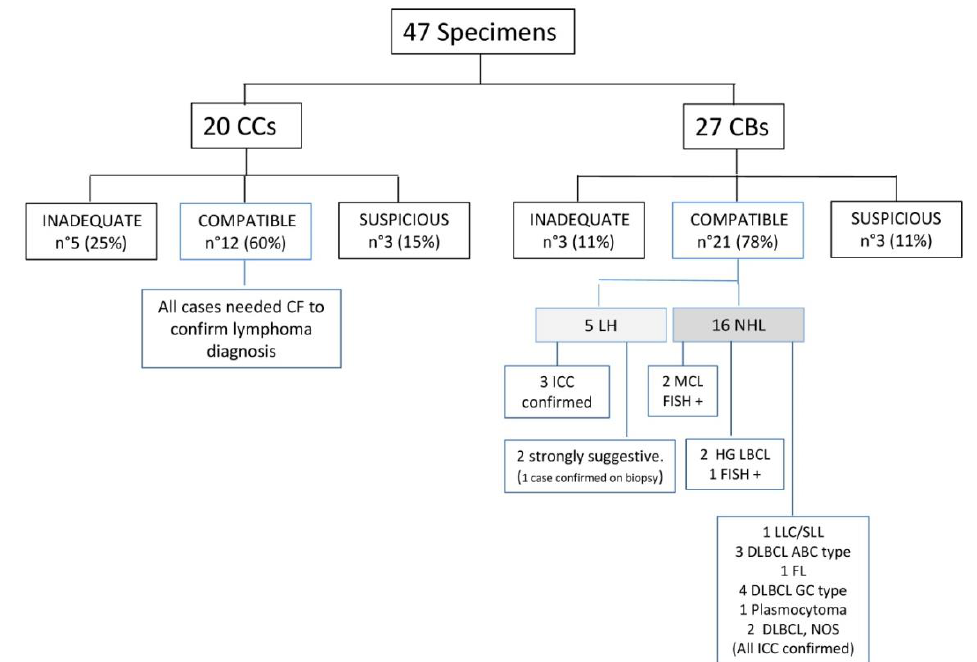
Figure 4. Diagnosis from CCs and CBs. CB: Cell Block; CC: Conventional Cytology; CLL/SLL: Chronic Lymphocytic Leukemia/Small Lymphocytic lymphoma; DLBCL, ABC-type: Diffuse Large B-cell lymphoma, Activated B-cell type; DLBCL, GCB type: Diffuse Large B-cell lymphoma, Germinal Center type; DLBCL, NOS: Diffuse Large B-cell lymphoma, Not Otherwise Specified; FISH: Fluorescence In Situ Hybridization; FL: Follicular lymphoma; HL: Hodgkin lymphoma, MCL: Mantle Cell lymphoma.